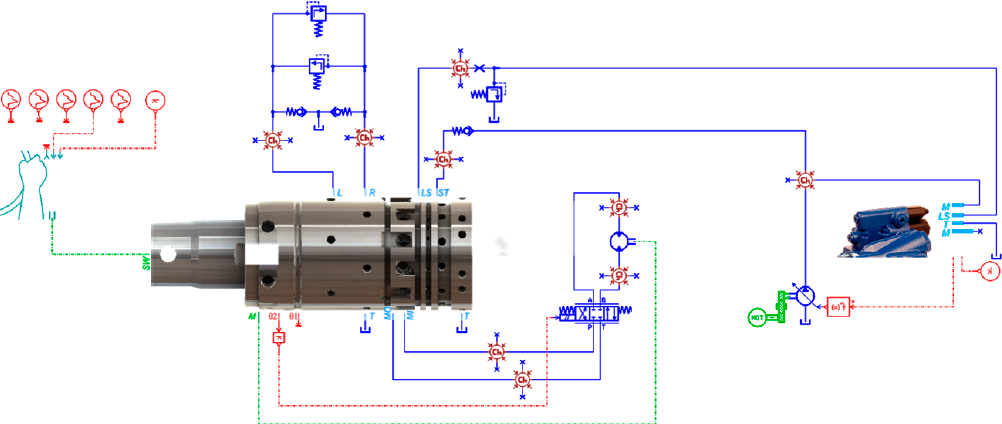
Figure 9. Model of the test rig used to test the hydrostatic steering unit. Table 1. Operating conditions tested in the test rig.